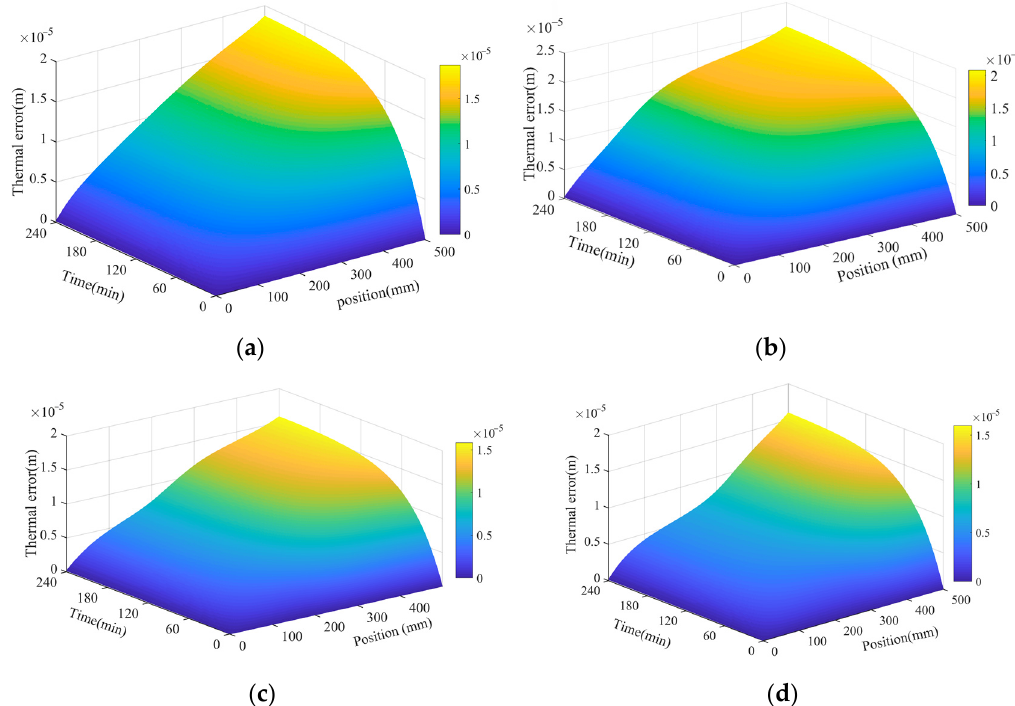
Figure 16. Simulation results of thermal error of ball screw feed system under different working conditions: ( a ) working condition 1; ( b ) working condition 2; ( c ) working condition 3; and ( d ) working condition 4.